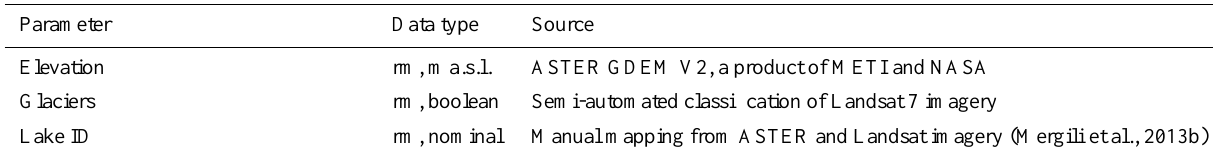
Table 1. Input data, rm – raster map, tc – table column.